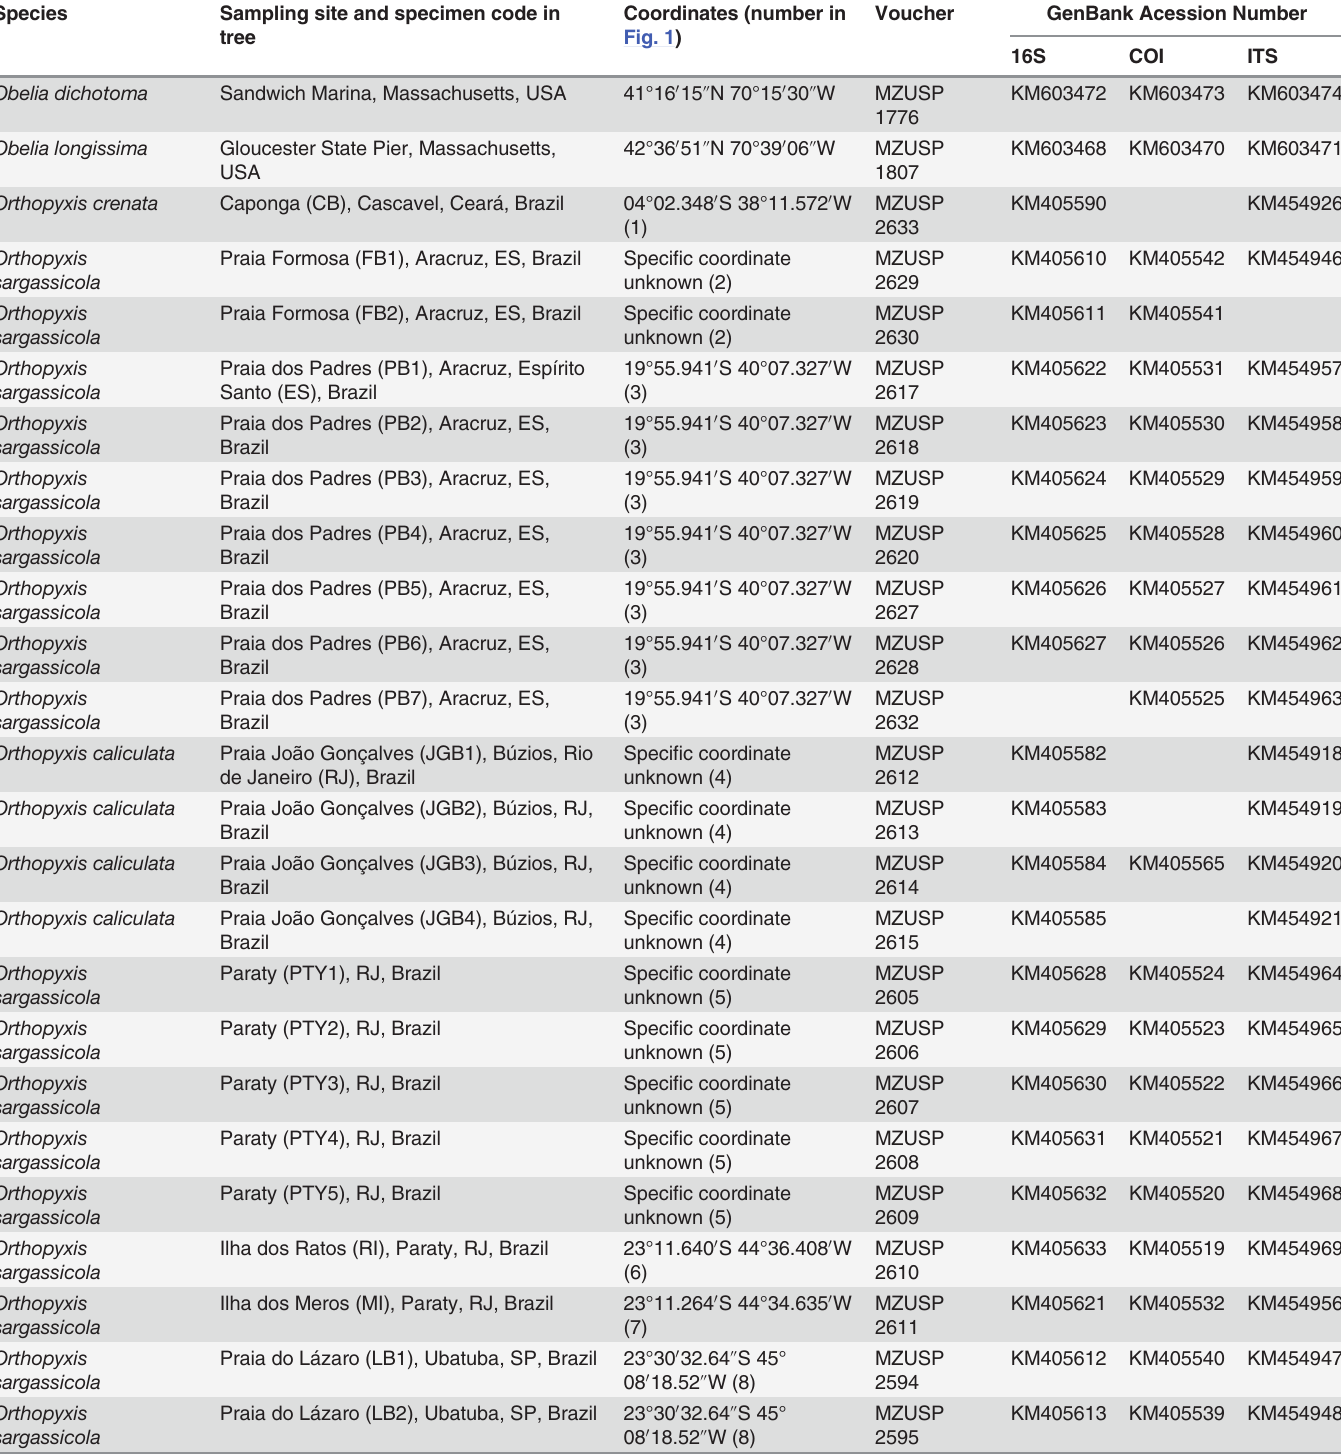
Table 2. Codes, sampling sites, museum vouchers and GenBank acession numbers for the specimens included in the phylogenetic analyses.